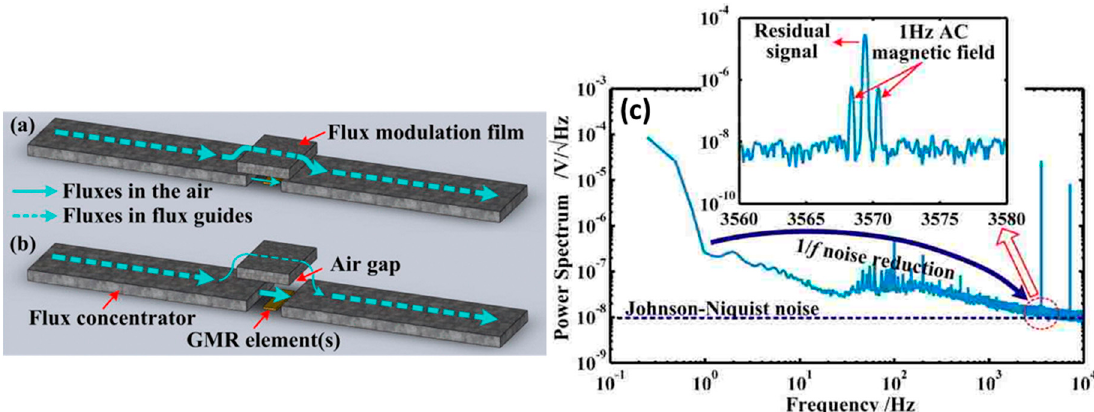
Figure 10. Schematic operating view of the VMFM based device: ( a ) cantilever gets close the sensing elements, reducing the magnetic flux through them; ( b ) cantilever moves upwards, restoring the magnetic flux in the sensing elements; ( c ) Acquired device output resulting from the modulation of a low-frequency AC field (1.2 μ T with a frequency of 1 Hz), exhibiting the respective sidebands when the cantilevers are actuated at the resonance frequency ( f 0 = 3.57 kHz). The residual signal at f 0 arises from the remanence of the Ni 79 Fe 21 flux modulation field and/or from an electric coupling between then sensing elements and the MEMS piezoelectric structure. Reprinted with permission from J. Hu et al. , Appl. Phys. Lett. 2012, 100 , 244102. Copyright 2012 AIP Publishing LLC.